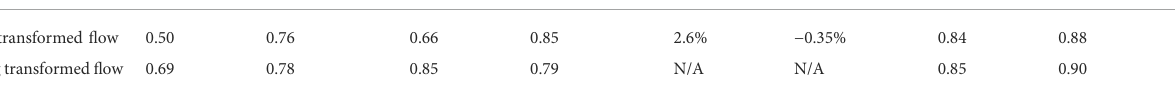
TABLE 4 Summary of statistical predictive performance metrics for the uncalibrated and calibrated NHM-PRMS model of a watershed near Cedar River, WA, based on daily stream fl ow, 1980 – 2016. NSE KGE PBIAS Model